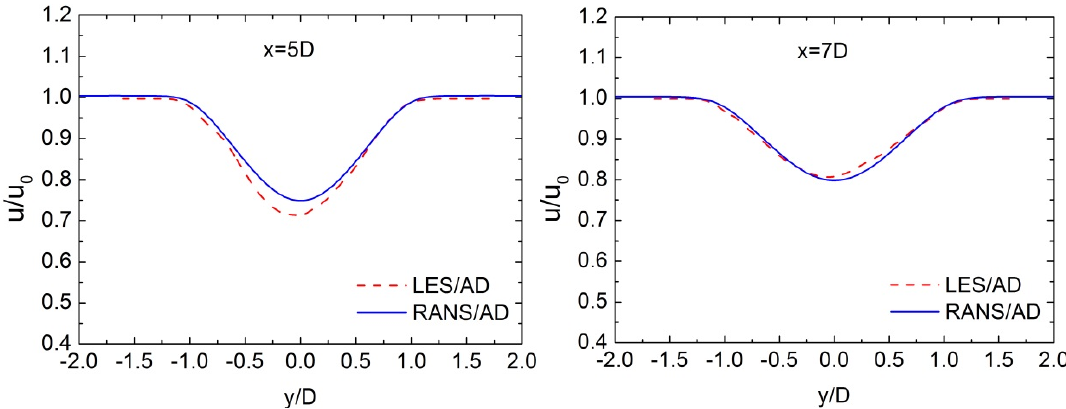
Figure 10. Comparisons of the normalized wake velocity from LES and RANS simulations, for down- stream locations of 5D and 7D after a single wind